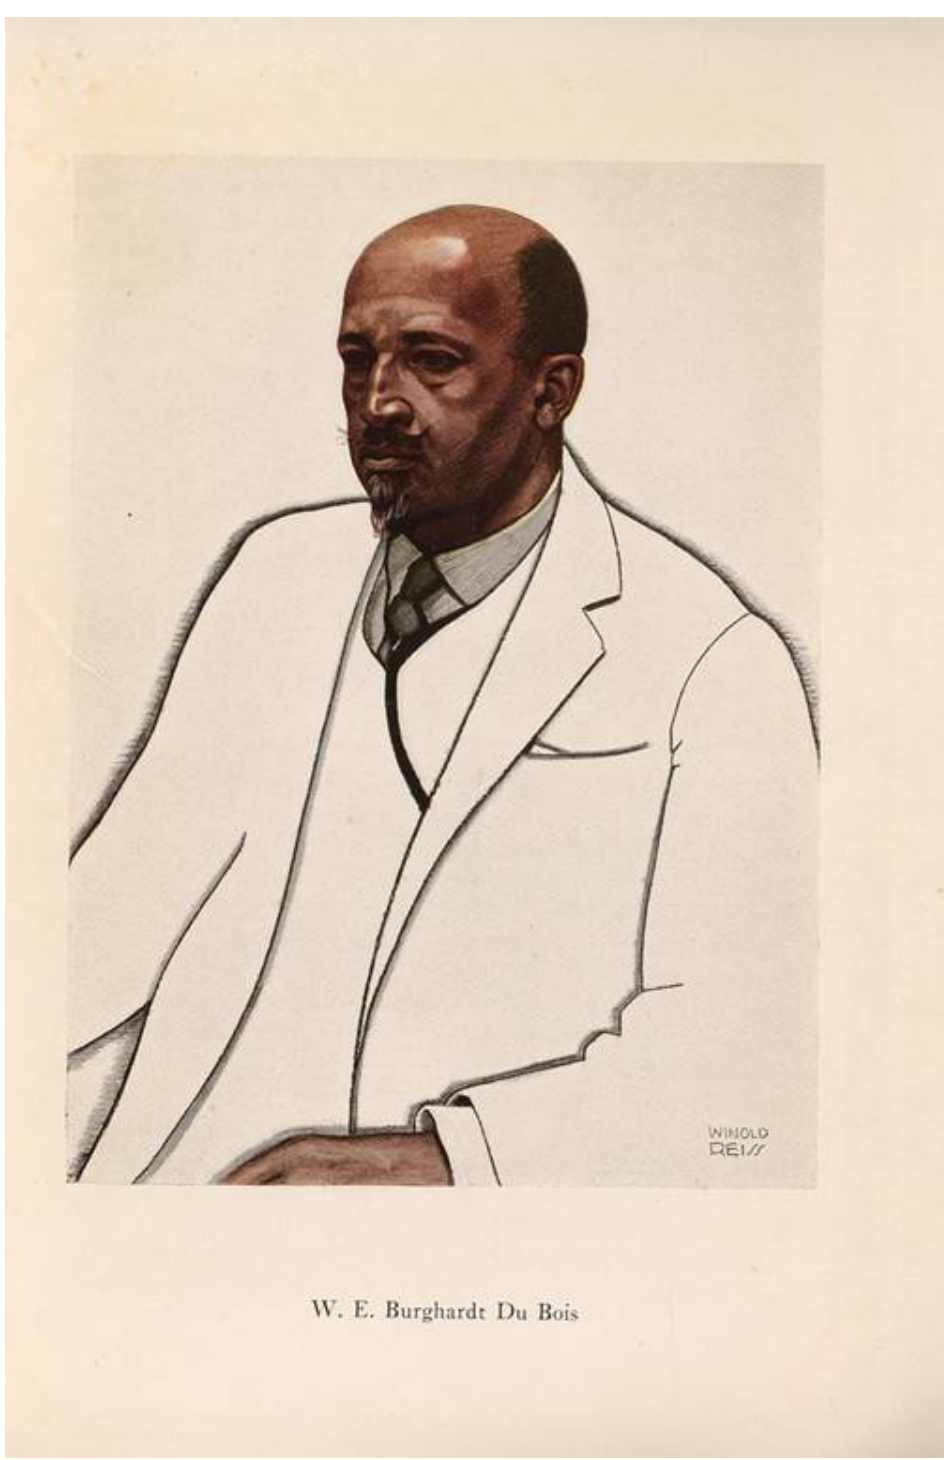
Figure 8 Winold Reiss, ‘Portrait: W. E. Burghardt Du Bois’, The New Negro: An Interpretation (1925), facing page 386 (Courtesy: National Portrait Gallery, Smithsonian